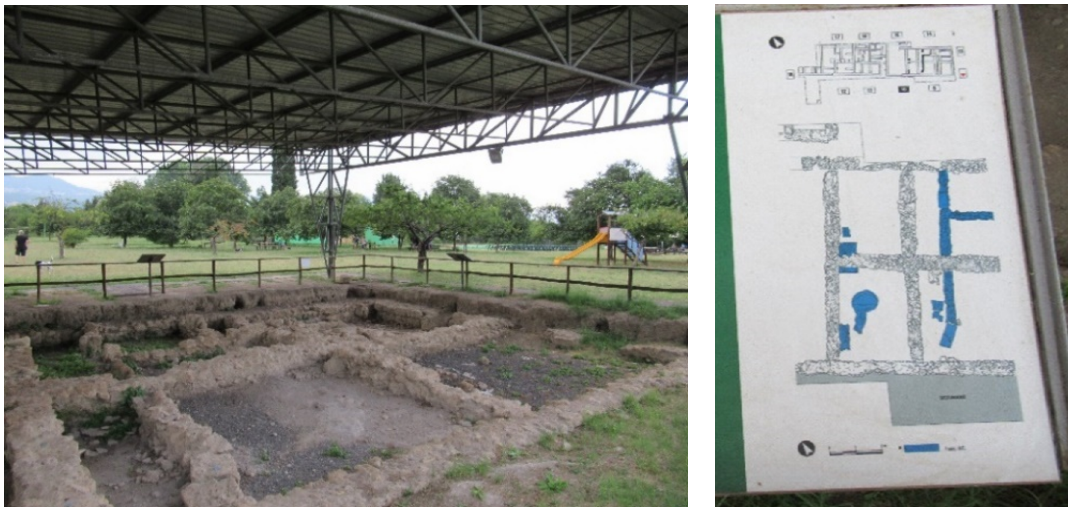
Figure 2. Example of a restorative dig site within the archaeological park in Pontecagnano, Salerno. Left—archaeological dig site; right—map of archaeological dig site. Source: Photographs taken by A. Russo on 16 July 2018.